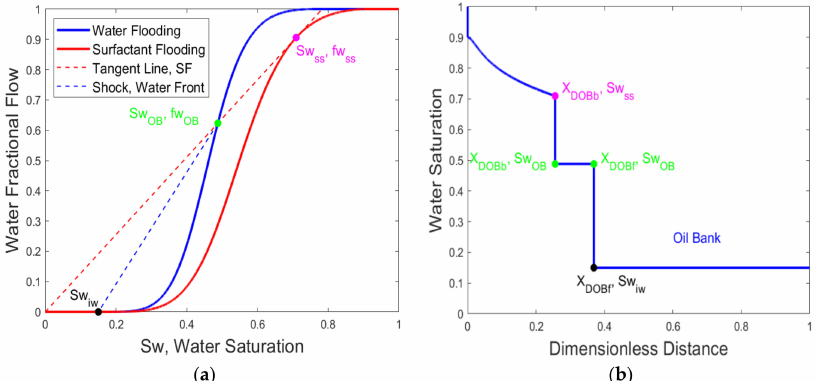
Figure 11. ( a ) Incremental oil recovery by surfactant flooding as a function of retardation factor; and ( b ) saturation profile at t D = 0.2 PV for di ff erent retardation